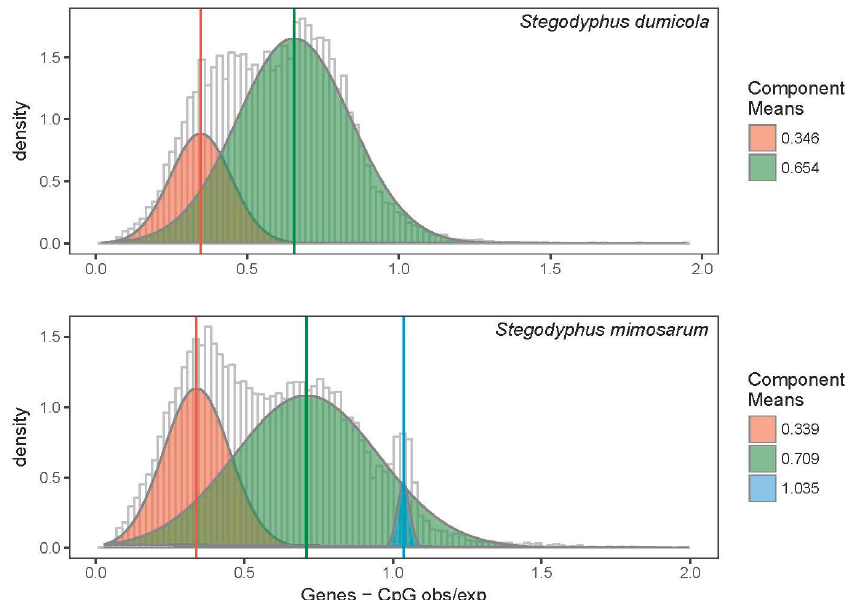
Figure 3. Frequency distribution of CpG O/E in protein coding genes of two social Stegodyphus species, S. dumicola and S. mimosarum . Predicted protein coding genes located in repetitive regions were excluded. Normal distributions were fitted to the data using the EM algorithm for normal mixtures. For S. dumicola , Peak 1 had a mean = 0.35 and a standard deviation = 0.10, while Peak 2 had a mean = 0.65 and a standard deviation = 0.19. For S. mimosarum , Peak 1 had a mean = 0.34 and a standard deviation = 0.11, Peak 2 had a mean = 0.71 and a standard deviation = 0.24, and Peak 3 had a mean = 1.04 and a standard deviation = 0.02.